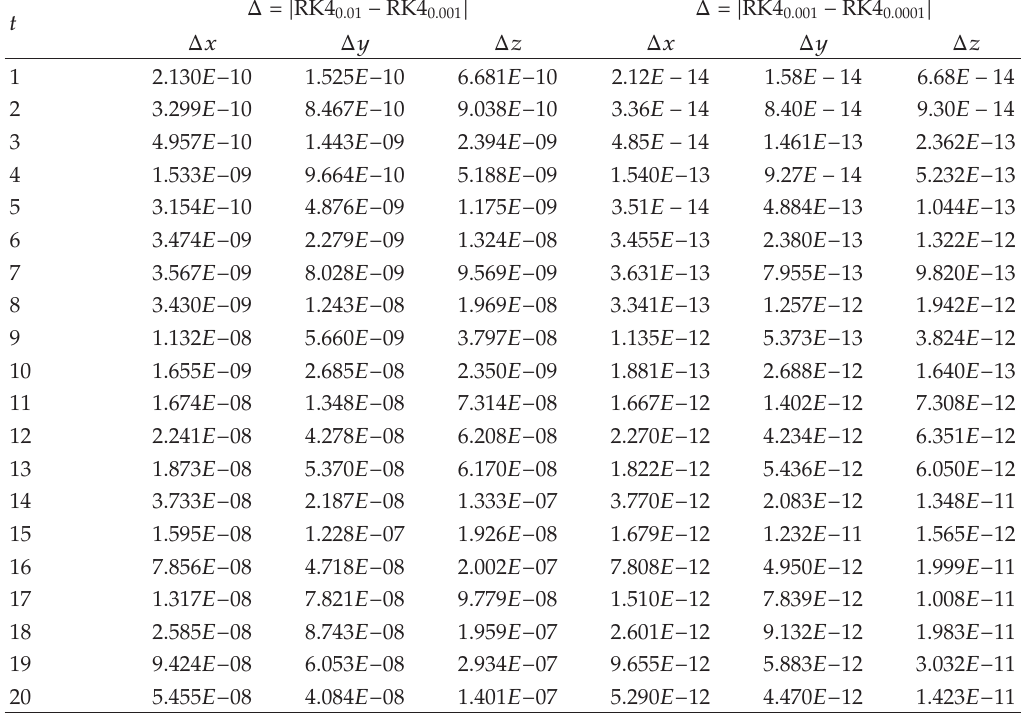
Table 1: A determination of the accuracy of RK4 for the Genesio system (cid:3) 1.1 (cid:4) .